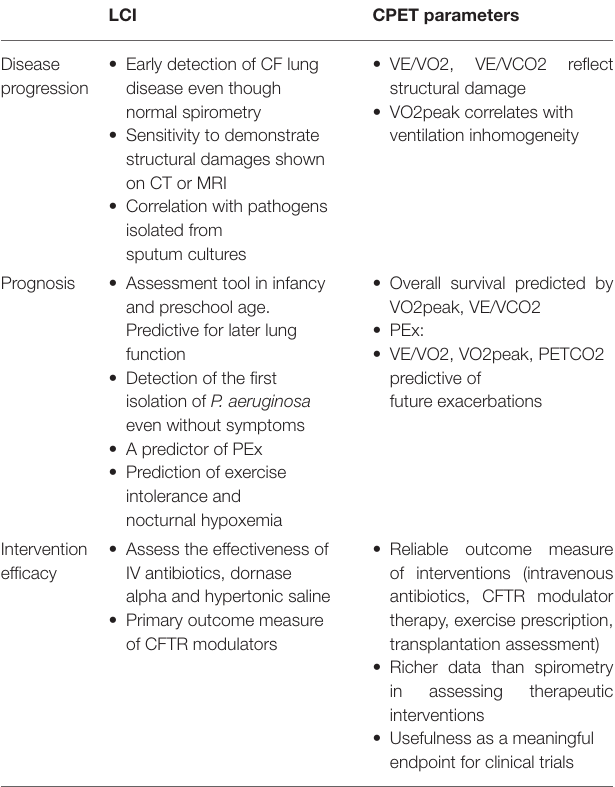
TABLE 1 | The role of LCI and CPET parameters in disease progression, prognosis, and intervention